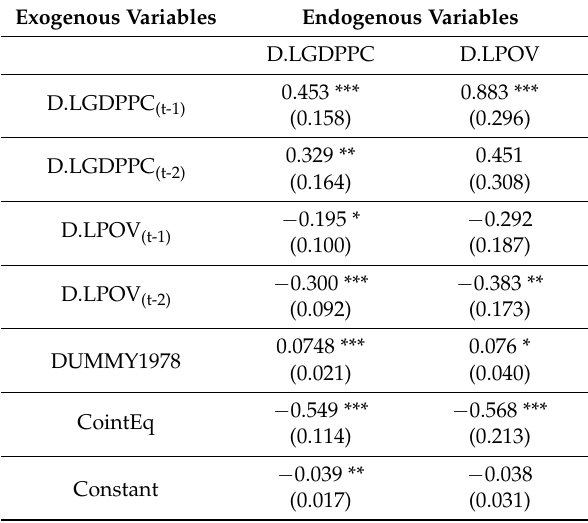
Table 4. Short-Run